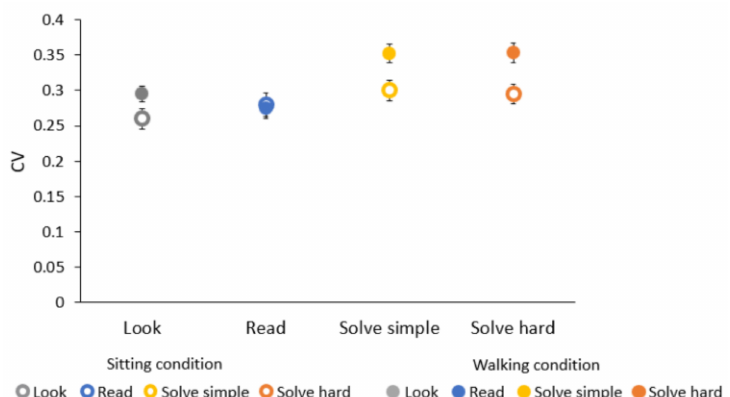
Figure 5. Coefficient of variation for different tasks in sitting and walking conditions. Data shown and their errors are the results of best linear fitting of binned RMSE as a function of estimated